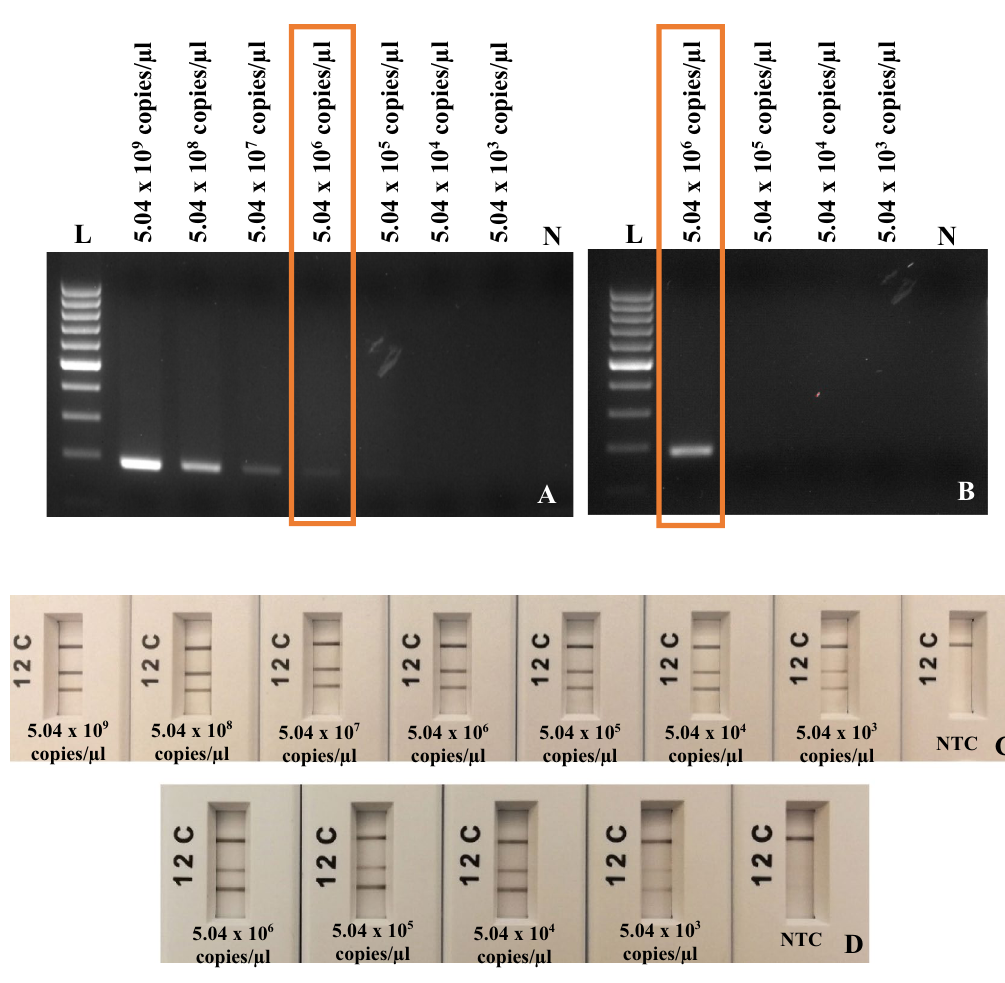
Figure 3. Limit of detection assays of A. ovis . ( A ) RPA-basic primers with ten-fold serial dilution of A. ovis plasmid from 5.04 × 10 9 to 5.04 × 10 3 copies/µl. ( B ) RPA-basic primers with ten-fold serial dilution of A. ovis total DNA from 5.04 × 10 6 to 5.04 × 10 3 copies/µl. Lane N, non-template control (NTC, water); lane L, 100 bp DNA ladder. ( C ) Multiplex RPA- nfo primers and probes using ten-fold serial dilution of Artificial Positive Control (APC). ( D ) Multiplex RPA- nfo primers and probes using ten-fold serial dilution of A. ovis total DNA from 5.04 × 10 6 to 5.04 × 10 3 copies/µl. Lane C, flow-check line; Lane 2, detects FAM/Biotin labelled amplicons ( A. ovis ); Lane 1, detects DIG/Biotin labelled amplicons (GAPDH—internal control); Lane N, non-template control